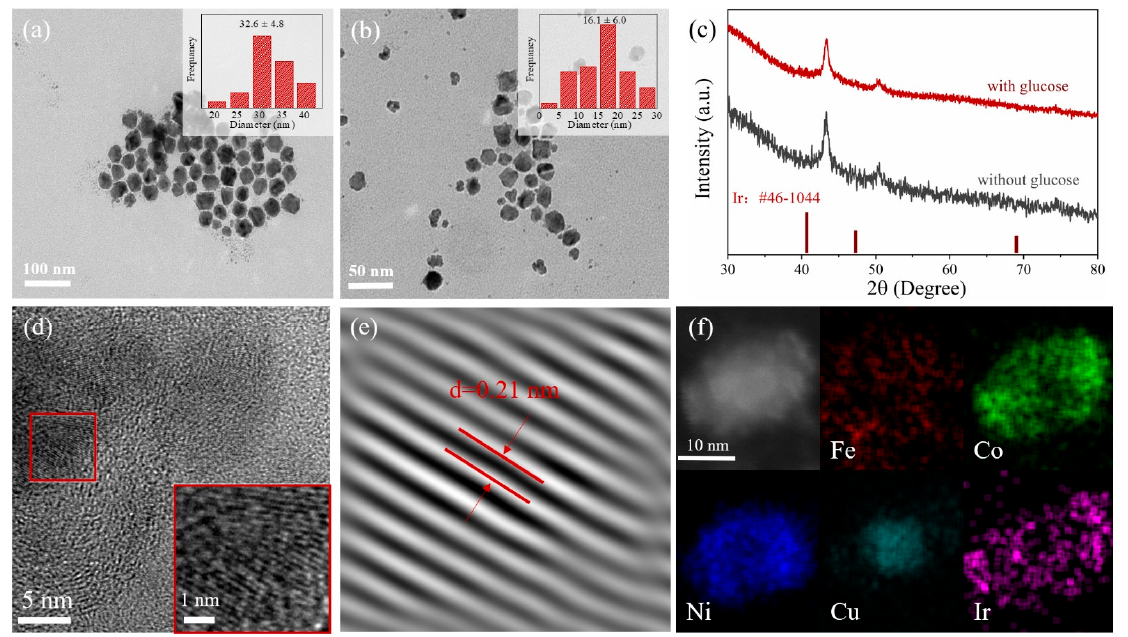
Figure 1. TEM images of FeCoNiCuIr HEA NPs and corresponding particle size distribution (insets) synthesized ( a ) with and ( b ) without the presence of glucose. ( c ) The X-ray diffraction pattern of FeCoNiCuIr HEA NPs. ( d ) HR-TEM, ( e ) corresponding FFT-filtered TEM, and ( f ) elemental maps of FeCoNiCuIr HEA NPs synthesized in the presence of glucose. Catalysts 2022 , 12 , x FOR PEER REVIEW